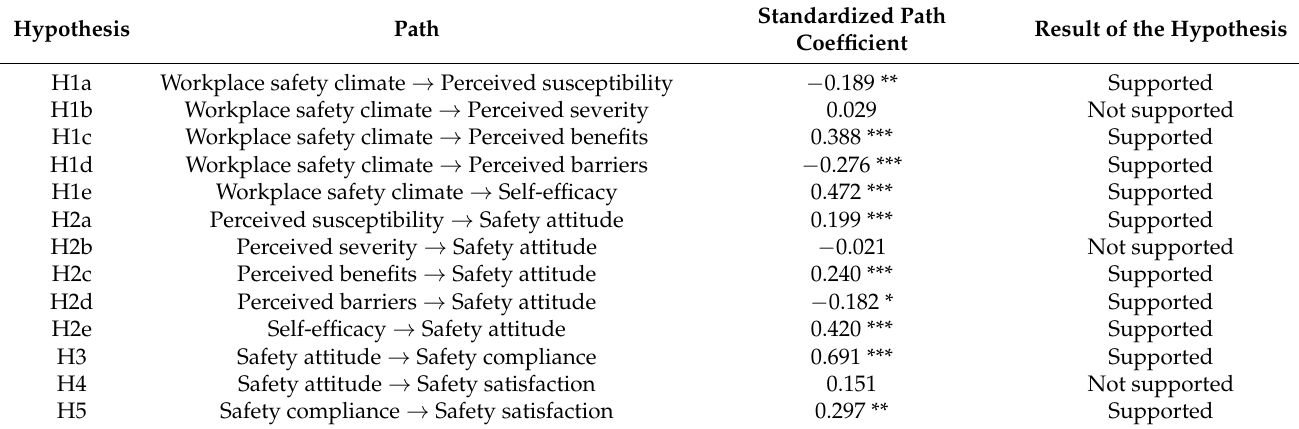
Table 4. Research hypotheses and test results.